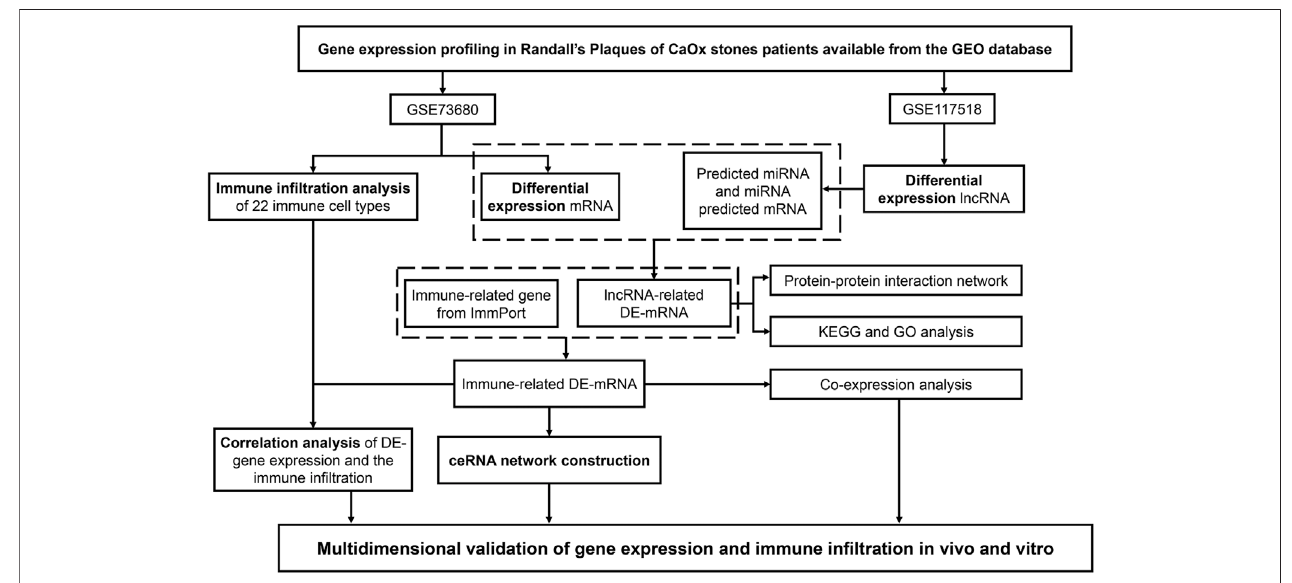
FIGURE 1 | Schematic representation of our analytic